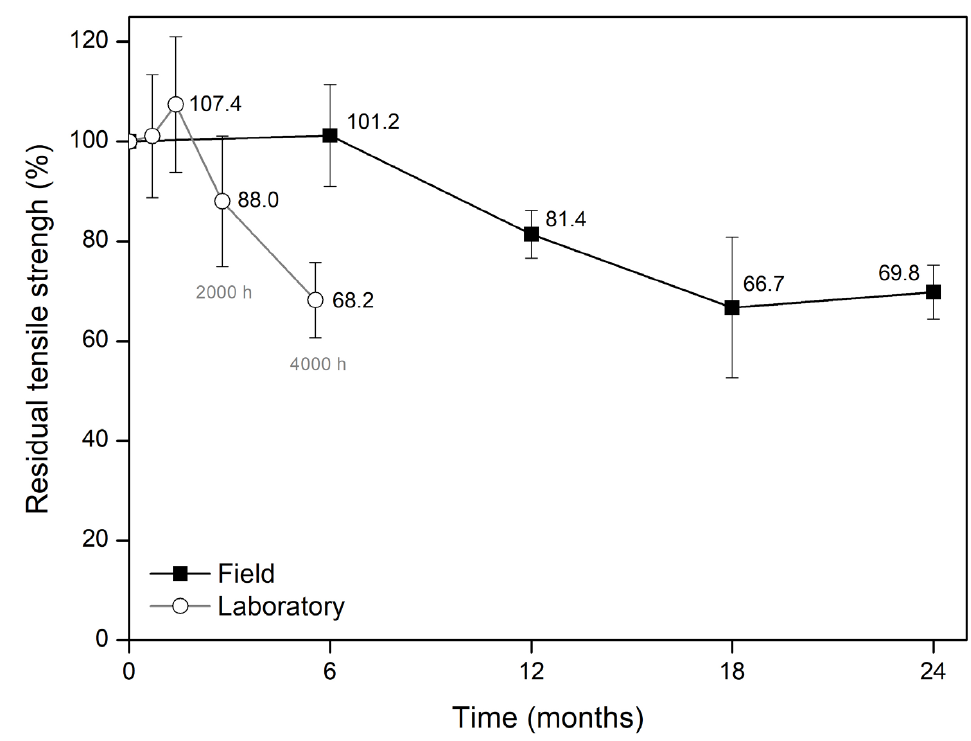
Figure 6. Comparison of the residual tensile strength of GT500 after the field and modified laboratory weathering tests.